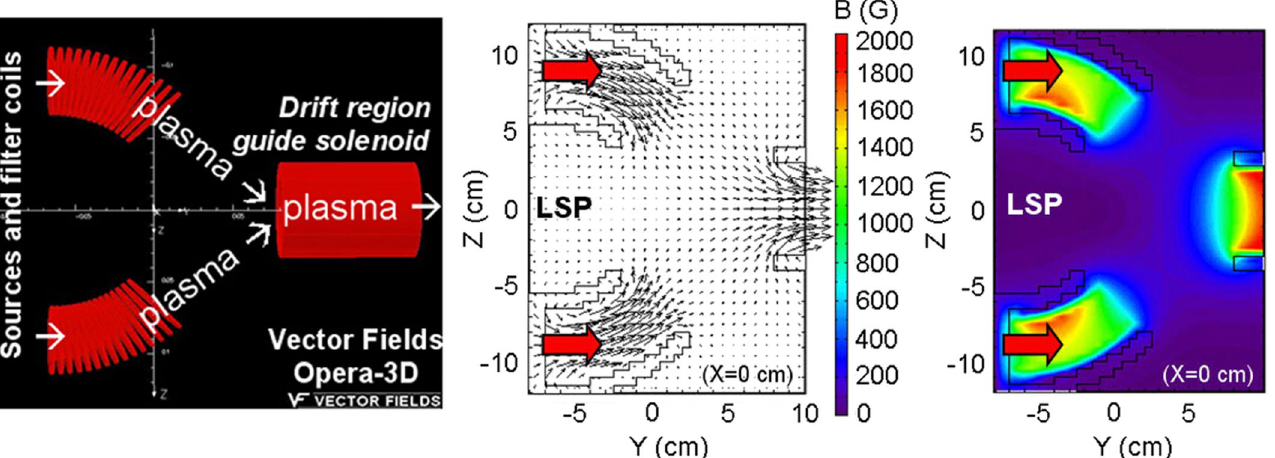
FIG. 4. (Color) Schematic and magnetic field topology from the FCAPS simulation (slices through the x (cid:6) 0 cm midplane are shown). Magnetic fields corresponding to the case in Fig. 3 (with curved filter coils) are calculated [26] by VECTOR FIELDS OPERA-3D [27] from the solenoid arrangement (left), and the resulting vector field (middle) and isocontours of total field magnitude (right) are initialized into the LSP code. White and red arrows show the intended plasma flow and location of the sources, respectively. The focal plane is near y (cid:6) 0 .